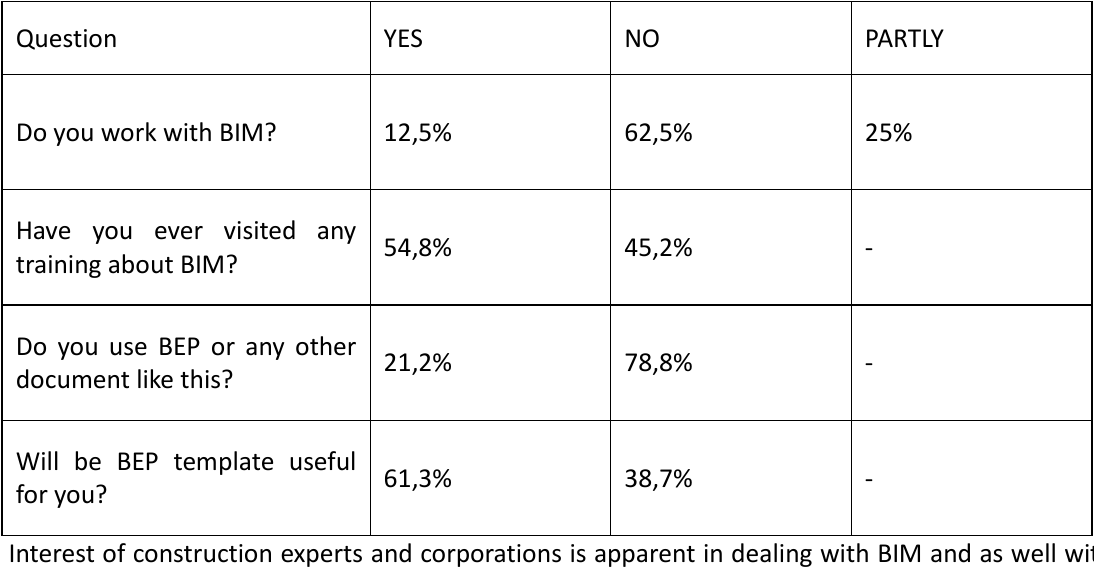
Table 1: Results of the survey